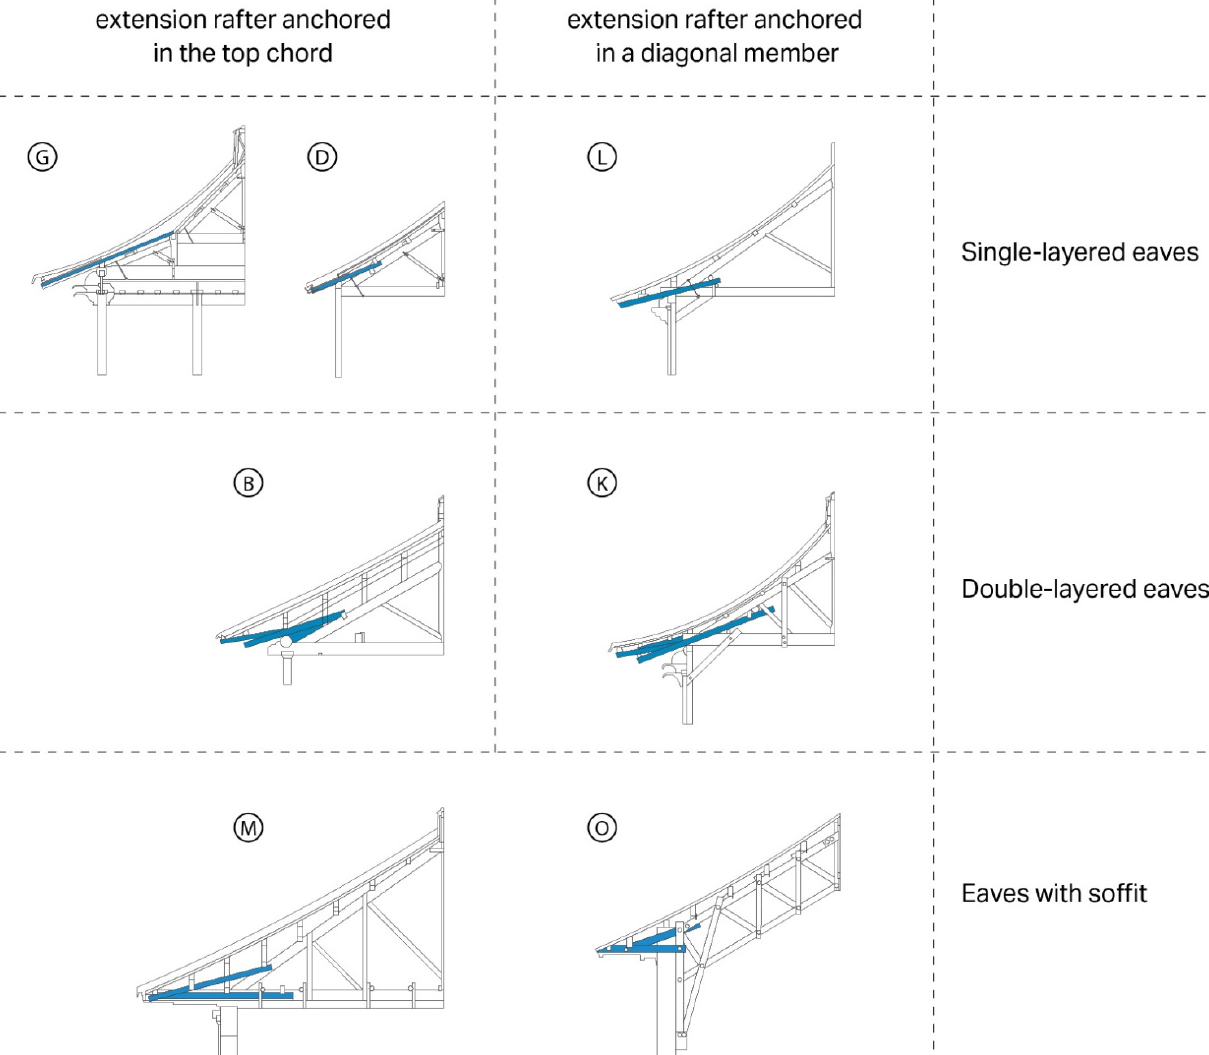
Figure 18. Protruding Eaves Achieved by Extension Rafters (Buyeon).